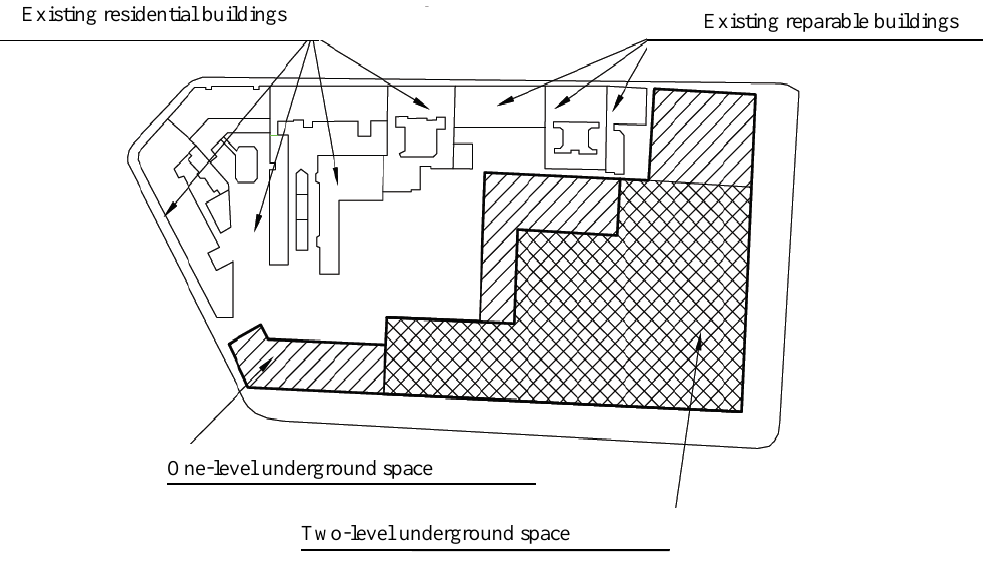
Figure 2. Schematic view of two-level underground